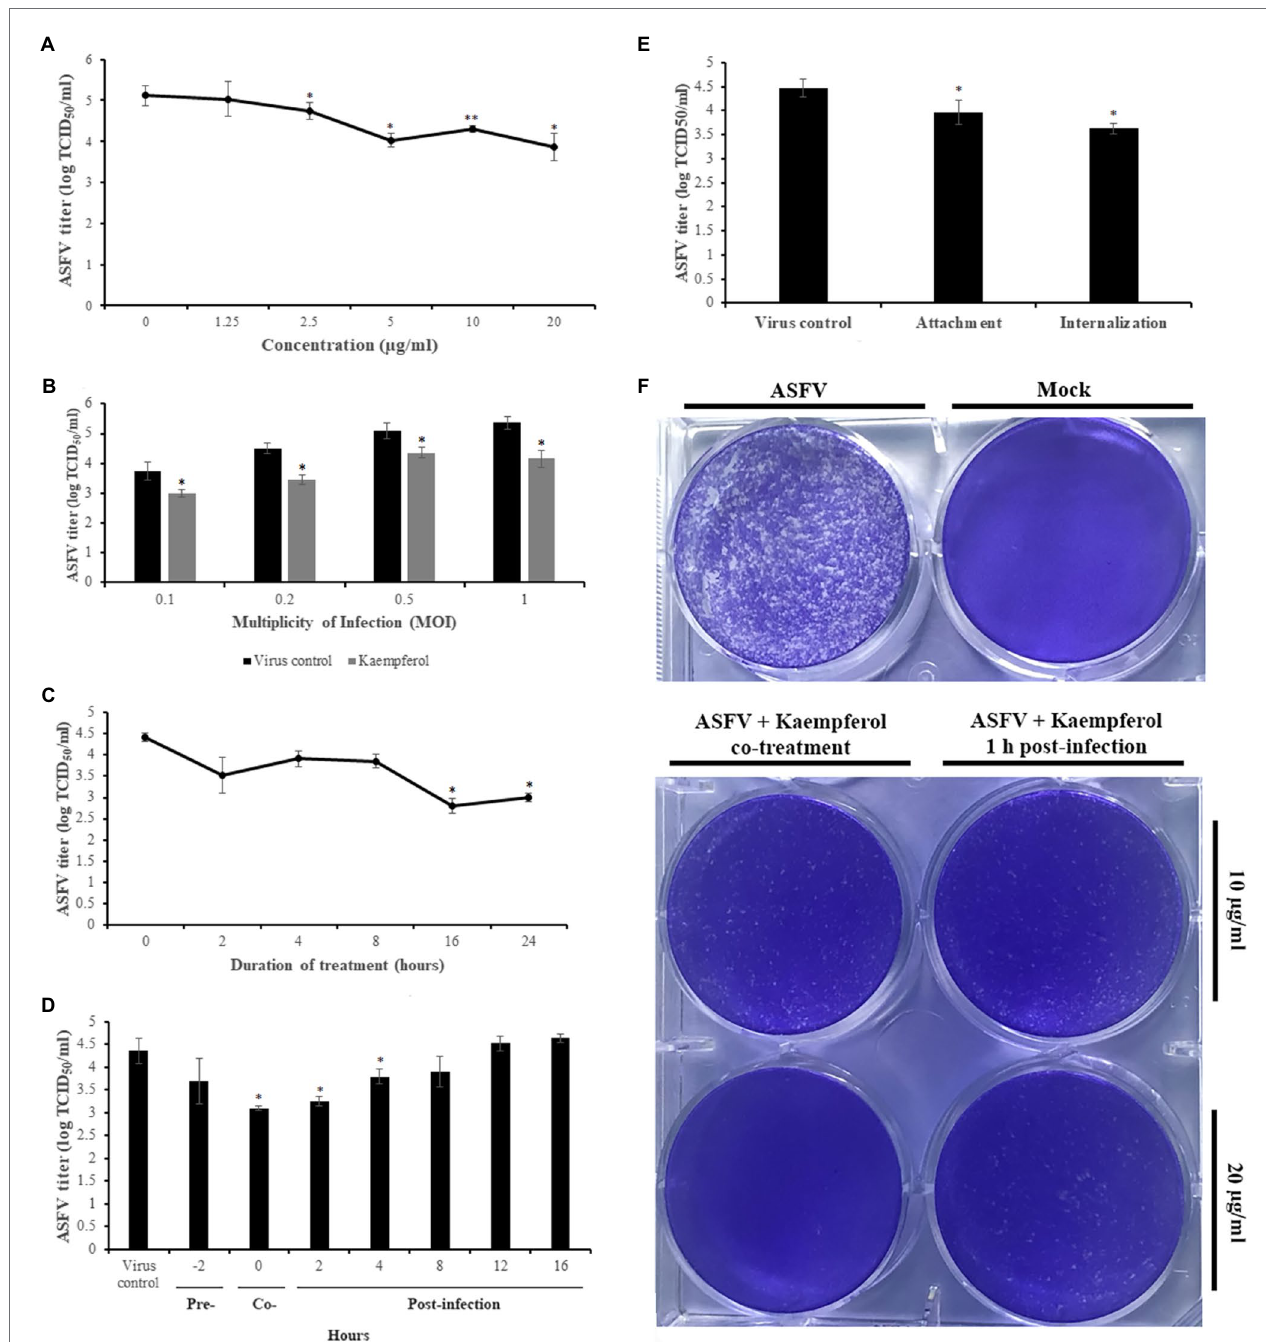
FIGURE 3 | Antiviral activity of Kaempferol against ASFV in Vero cells. (A) ASFV titer in cells exposed to kaempferol at increasing concentrations from 1.25 μ g/ml (4.3 μ m) to 20 μ g/ml (70 μ m). (B) Effect of kaempferol on Vero cells infected with ASFV at different MOIs. (C) Time-of-removal effect of kaempferol on ASFV-infected cells to determine the optimal treatment time. (D) Antiviral activity of kaempferol depending on the time of addition. (E) Effect of kaempferol treatment on ASFV entry stage. (F) ASFV spread in cells treated with kaempferol. The concentration of tested compound on in the experiments in panels (B) , (C) , (D) , and (E) was 20 μ g/ml. Results represent the mean (± SD) of three independent experiments ( n = 3). Significant differences compared to control are denoted by * p <